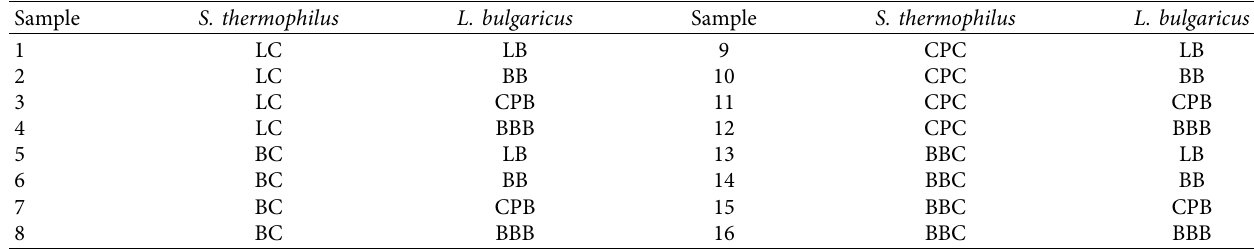
Table 2: Yoghurt combinations used in the